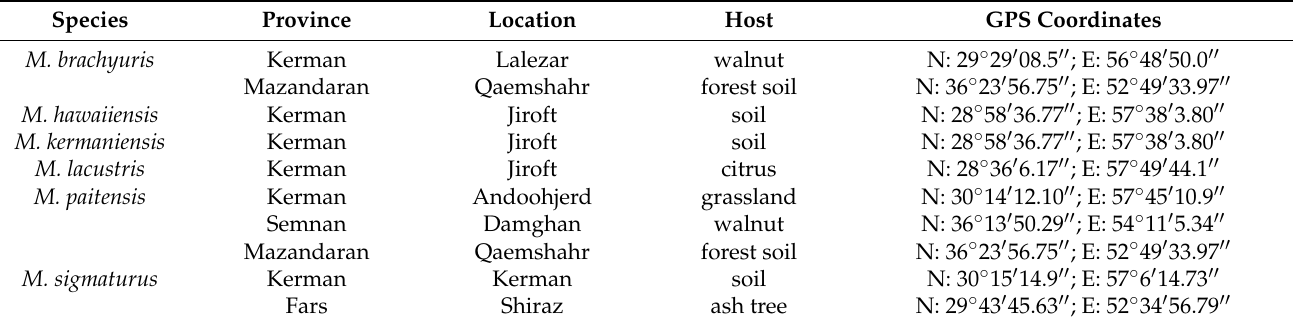
Table 1. Geographic locations and coordination of the species